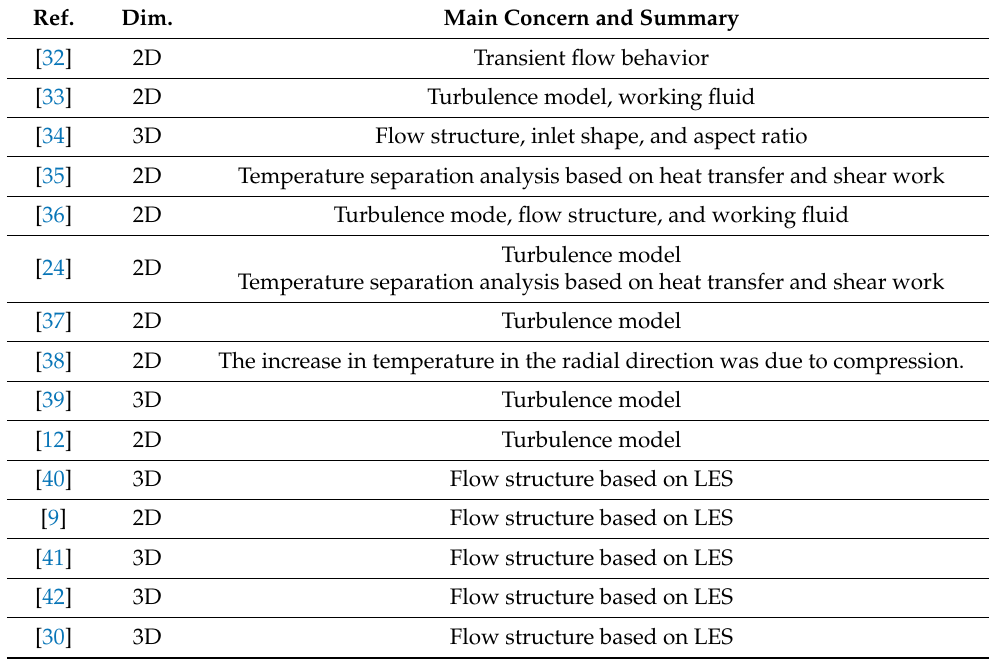
Table 1. Previous numerical simulation works. Ref.